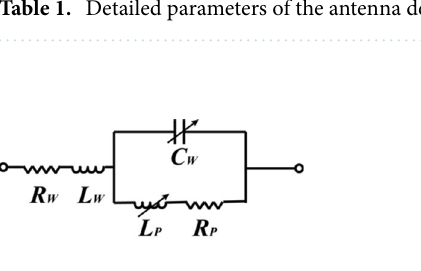
Figure 3. Equivalent circuit of the photodiode LXD1616R.